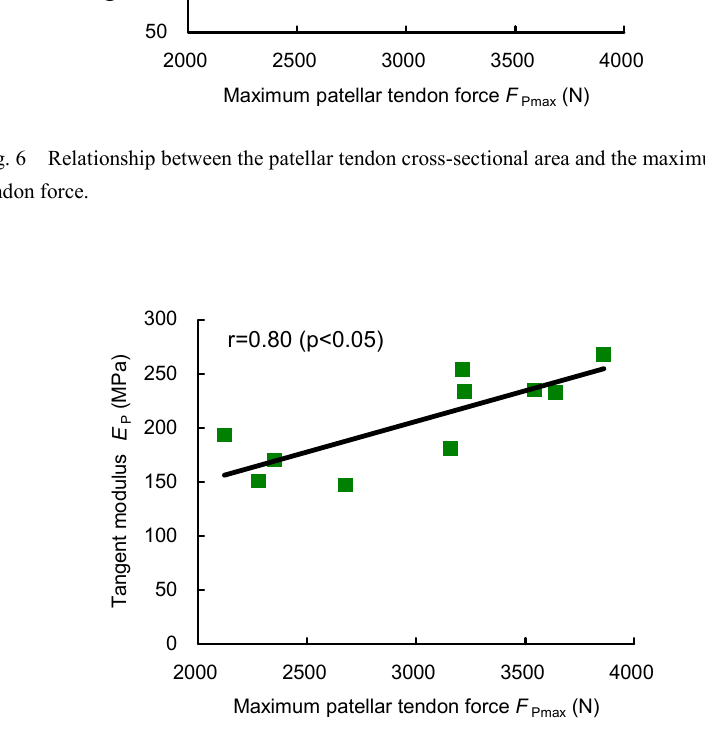
Fig. 7 Relationship between the patellar tendon tangent modulus and the maximum patellar tendon